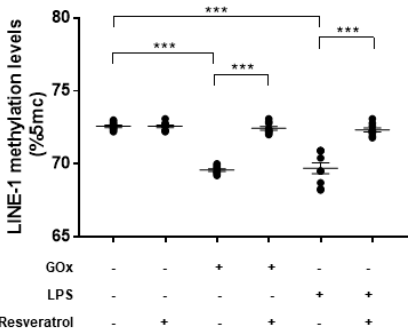
Figure 4. LINE-1 methylation levels in ARPE-19 cells under oxidative stress and inflammatory conditions. Compared to controls (72.6%5mc ± 0.1), LINE-1 methylation levels were lower in GOx- (69.6%5mc ± 0.1; p < 0.0001)- and LPS- (69.7%5mc ± 0.4; p < 0.0001) treated cells. Treatment with 10 µM resveratrol for 24 h restores LINE-1 methylation levels in cells under oxidative stress (72.4%5mc ± 0.1; p > 0.05) and inflammatory (72.3%5mc ± 0.1; p > 0.05) conditions. The experiments were performed in